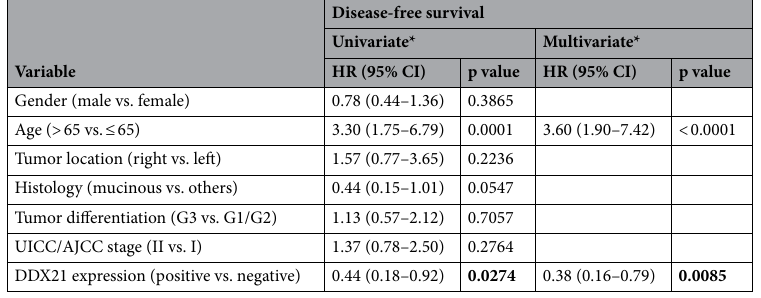
Table 3. Univariate and multivariate analyses of early stage MSI colorectal cancer (UICC/AJCC stages I and II combined). p values for DDX21 < 0.05 are indiacted in bold HR, hazard ratio; CI, confidence interval. *Cox proportional hazards